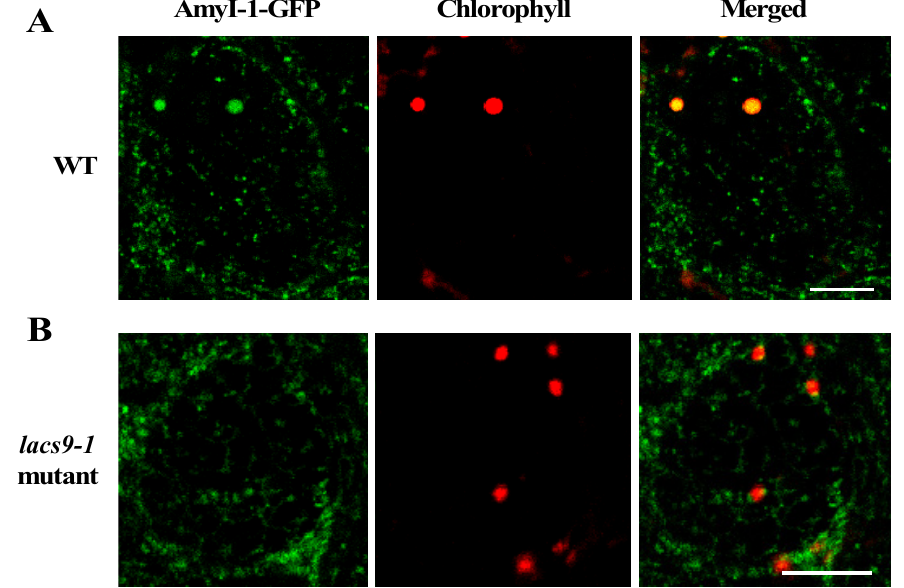
Figure 3. Prevention of α -amylase isoform I-1 (AmyI-1) chloroplast localization in lacs9-1 mutant cells. Confocal laser scanning-microscopic images of chloroplasts in ( A ) WT and ( B ) lacs9-1 rice cells with expression of AmyI-1-green fluorescent protein (GFP). Red and green colors show the fluorescence signals of chlorophyll and GFP, respectively. Bars = 5 µm.